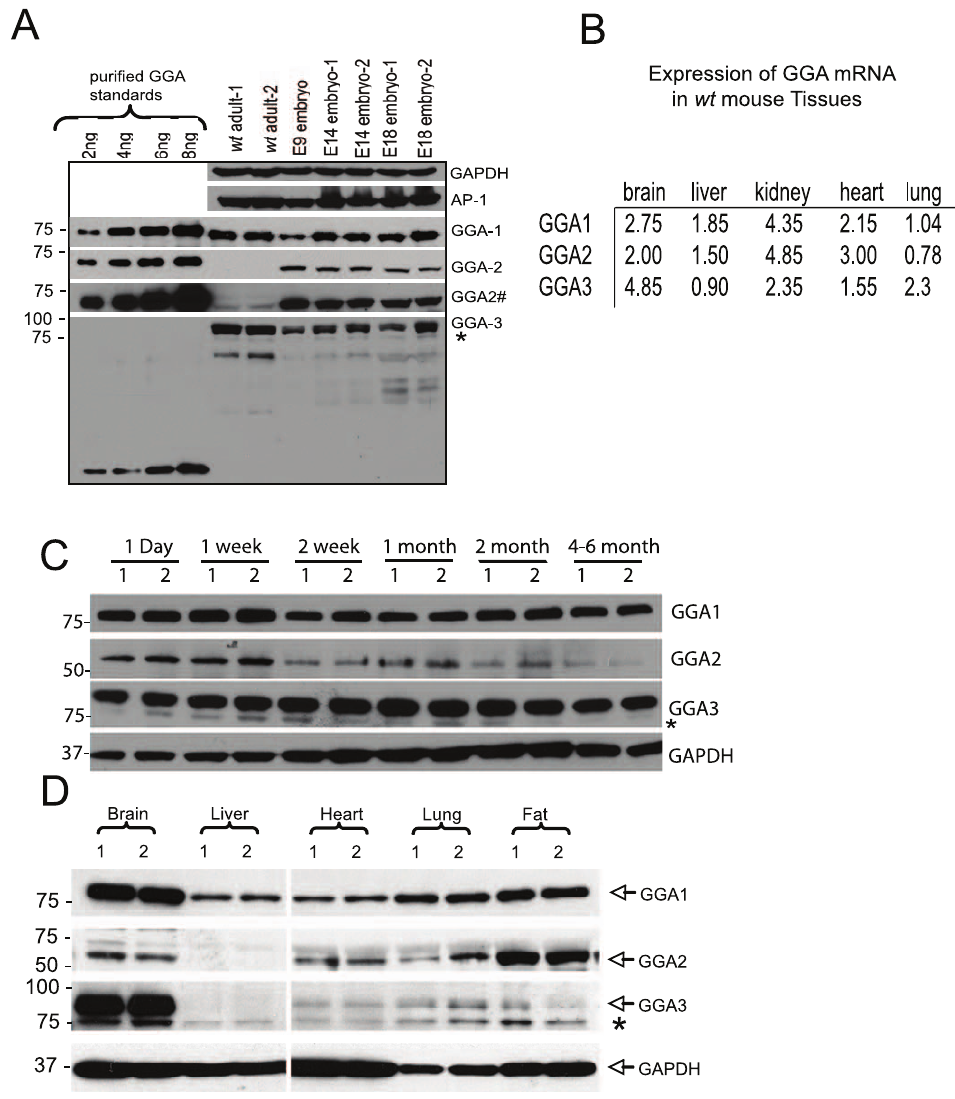
Figure 5. Tissue expression of GGA proteins. A) 25 m g of E9 whole embryo and E14, E18 and adult brain lysates along with 2–8 ng of purified standards were subjected to SDS-PAGE and immunoblot analysis. GGA1 and GGA2 purified standards were full-length Flag-tagged mouse proteins while the GGA3 standard was the mouse protein encoding only the VHS-GAT domain (see Figure S4A). Blots were probed for GGA1, GGA2, GGA3, AP- 1 and GAPDH. Quantitation was derived from comparison to the GGA standards. # denotes a longer exposure of the GGA2 Western blot. B) The mRNA levels in mouse tissues were determined by quantitative realtime PCR and expressed relative to the expression of b -actin. First strand cDNA was synthesized from total RNA by reverse transcription as described in Materials & Methods. Realtime PCR was performed with SYBR Green Kit (ABI). The values presented are the average of two independent runs with total RNA isolated from the indicated organs of a wt mouse of C57BL/6J-129/Ola mixed genetic background. C) 25 m g of wt mouse brain lysates from mice (day 1 through adult stage) were subjected to SDS-PAGE and immunoblot analysis. Blots were probed as in panel A. D) 25 m g of wt adult mouse lysates (brain, liver, heart, lung and fat) were subjected to SDS-PAGE and immunoblot analysis. Blots were probed as in panel